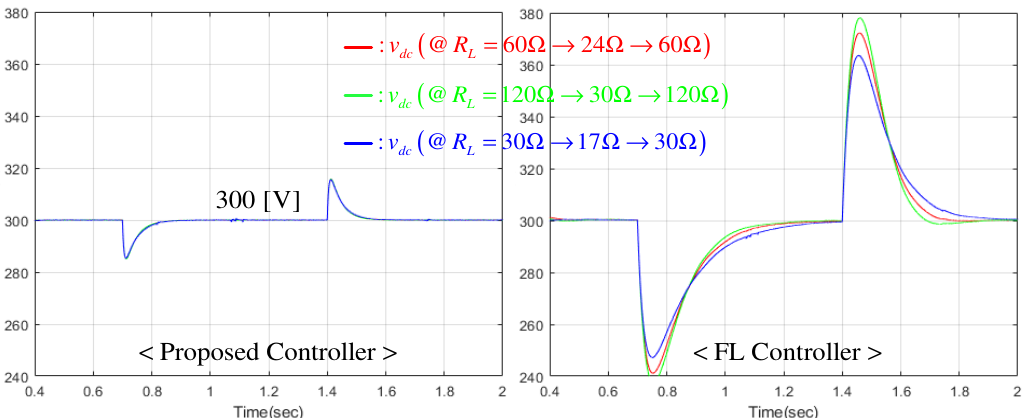
Figure 7. DC-link voltage regulation behavior changes under three resistive load change scenarios: